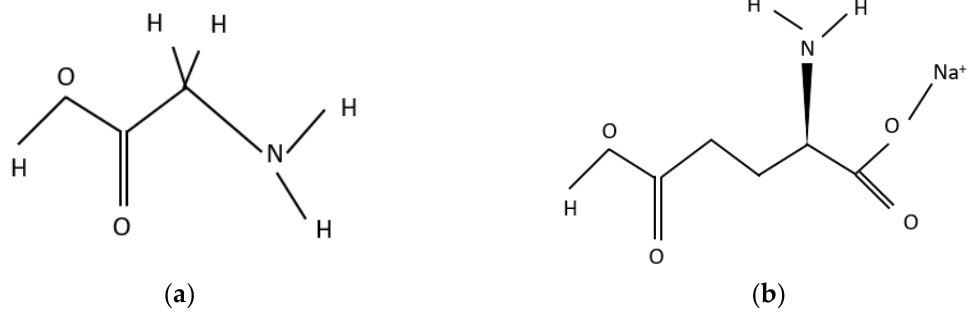
Figure 1. Molecular structure: ( a ) glycine, ( b ) monosodium glutamate. Source: Pubchem https://pubchem.ncbi.nlm.nih.gov/compound/750; https://pubchem.ncbi.nlm.nih.gov/compound/23672308 (accessed on 24 October 2022).